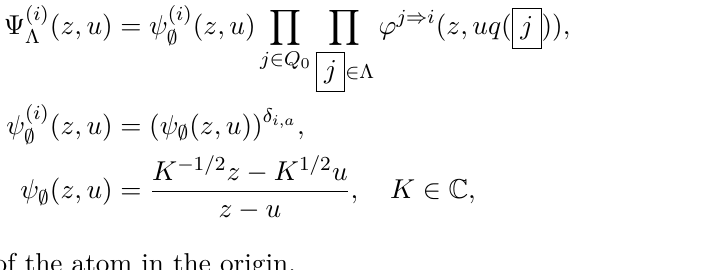
= (0 , 1) , p = (0 , 0) , and p = (1 , 0) . All of them are corner divisors. 1 2 3 , ‘ , and ‘ 1 2 3